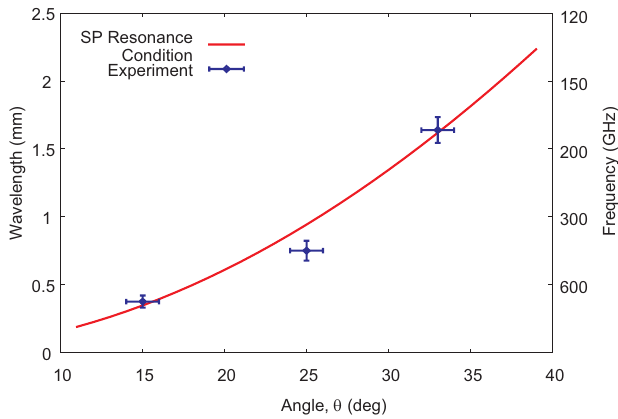
FIG. 2. (Color) Plot of the Smith-Purcell resonance condition and the measured experimental data for the 10 mm grating.